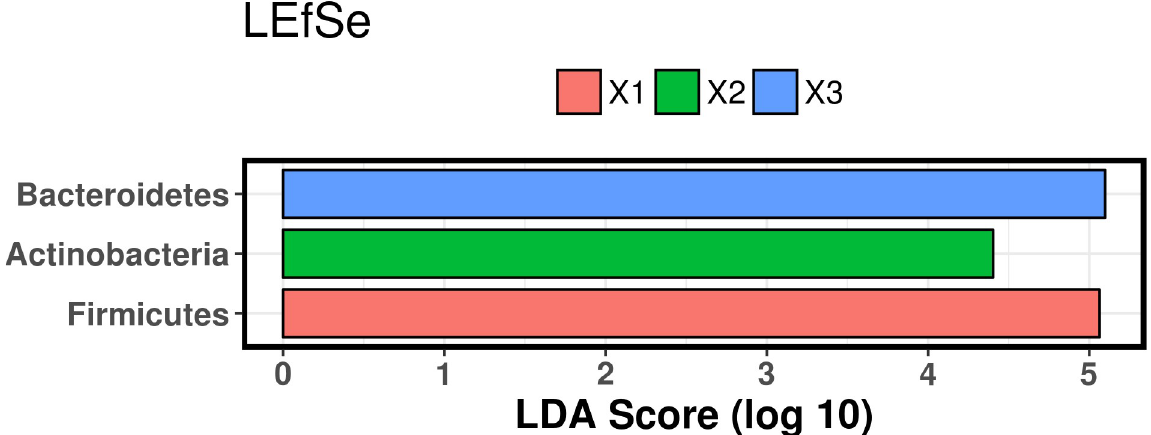
Fig 5. Linear discriminant analysis effect size (LEfSe) of bacterial phyla in feces from juvenile green turtles. Samples were collected at three time points throughout rehabilitation (X1 = admission, X2 = mid-rehabilitation, X3 = recovery).